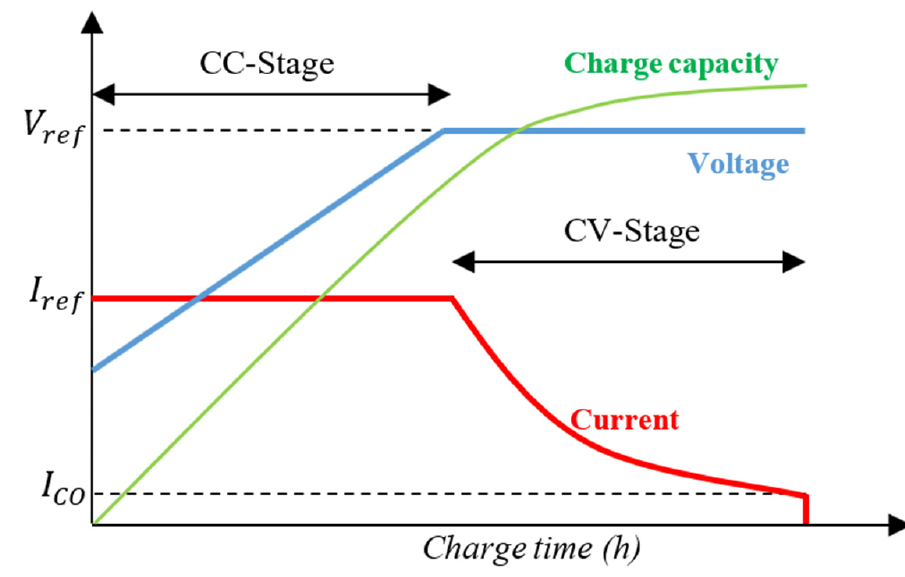
Figure 30. CC-CV battery charging strategy profile.